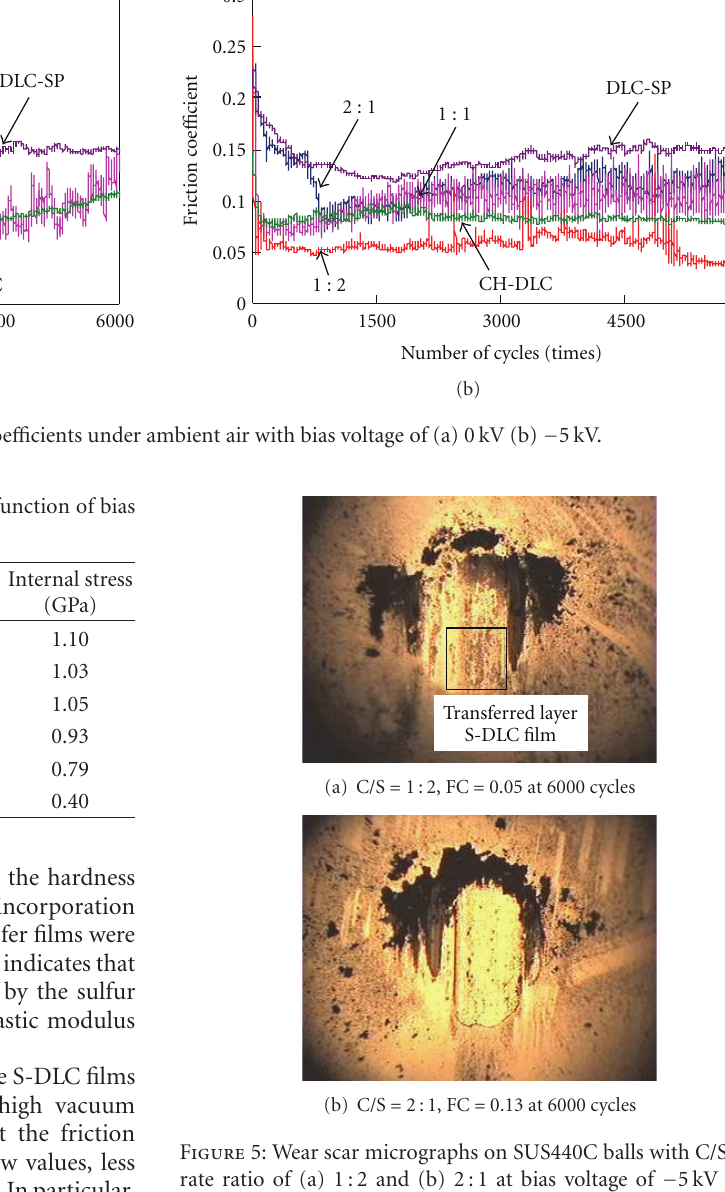
coe ffi cient at a C/S flow-rate ratio of 2 : 1 does not show